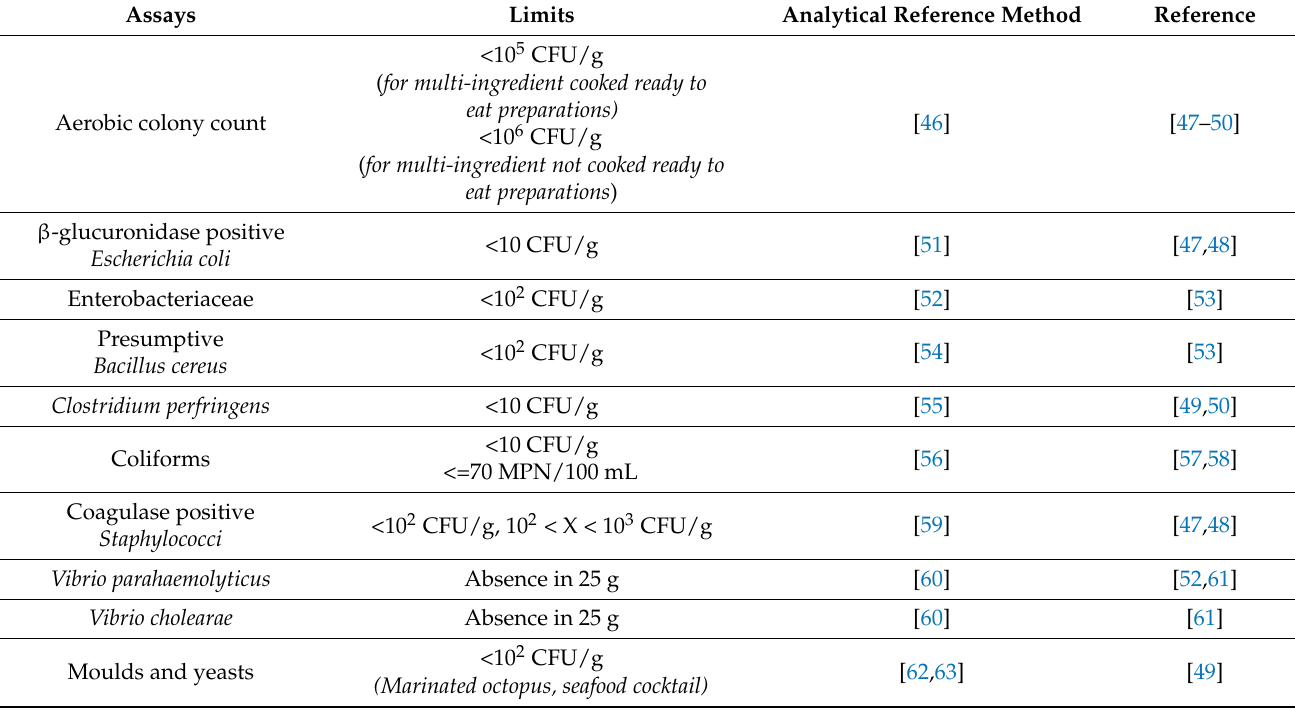
Table 2. Main parameters chosen for safety analysis of seaweed-based fermented food